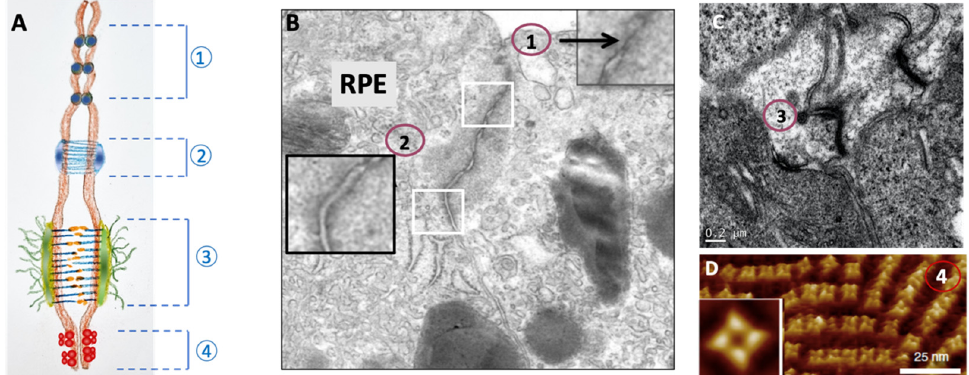
Figure 1. ( A ) Schematic representation of the different types of junctions allowing contact between cells (zonula occludens or tight junction (1), zonula adeherens (2), macula adherens, or desmosomes (3) and gap junctions or connexon (4)). ( B ) Microphotographs of retinal pigment epithelium (RPE) using transmission electron microscopy images of tight junction (1) and zonula adherens (2). ( C ) Microphotograph of glial Müller cells at the outer limiting membrane showing desmosome (3). ( D ) Atomic force micrograph of the connexons formed by AQP0 in the lens (4).